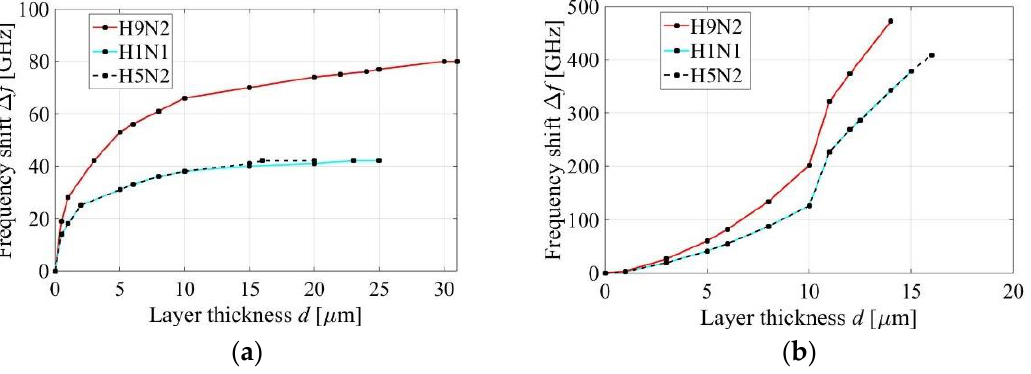
Figure 10. Detection curves around the first peak for ( a ) SquarePMA and ( b ) CrossPMA. Table 3. Numerical representation of sensitivity parameters around the first peak for SquarePMA.